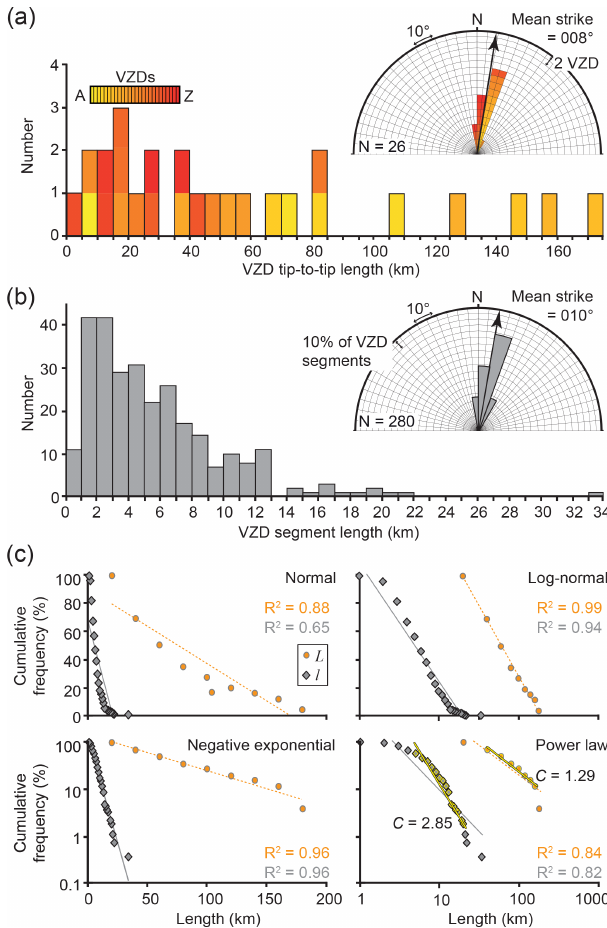
Figure 10. (a) Plot of VZD line length and rose diagram of VZD tip-to-tip strike. (b) Plot of VZD segment length and rose diagram of VZD segment strike. (c) Cumulative frequency plots of VZD line length ( L ) and segment length ( l ) to assess whether data fits normal, log-normal, negative-exponential, or power-law distributions. Best- fit trend lines for both datasets reveal they conform with log-normal or negative-exponential distributions. If the curved sections of the data distribution on the power-law plot are discounted, the VZD L and l data display a straight line with a populationexponent (C) of 1.29 and 2.85, respectively.